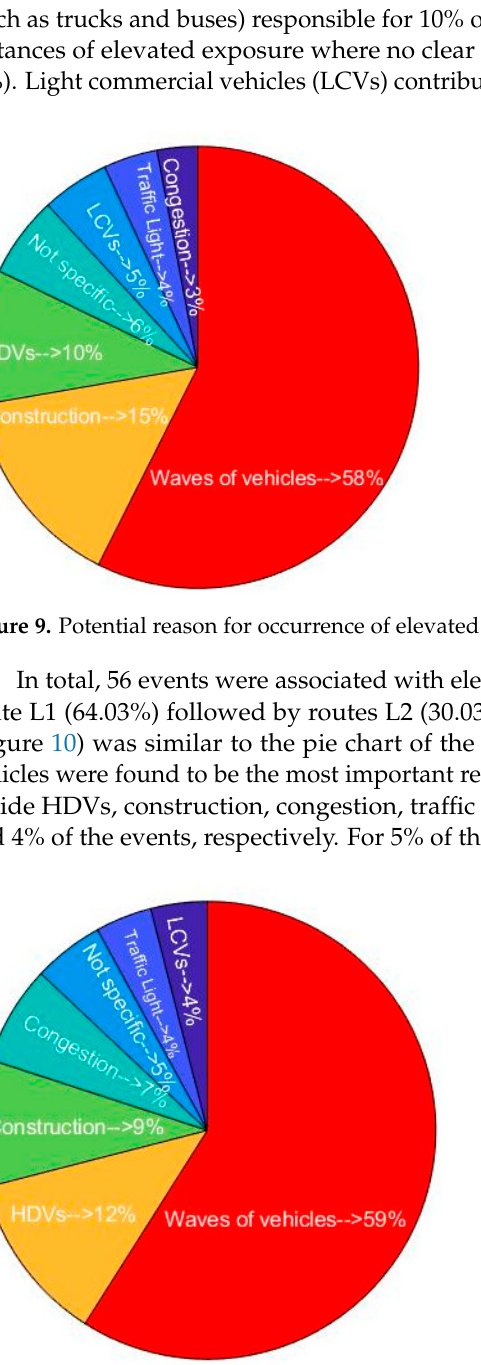
Figure 10. Potential reason for events resulting in elevated exposures.